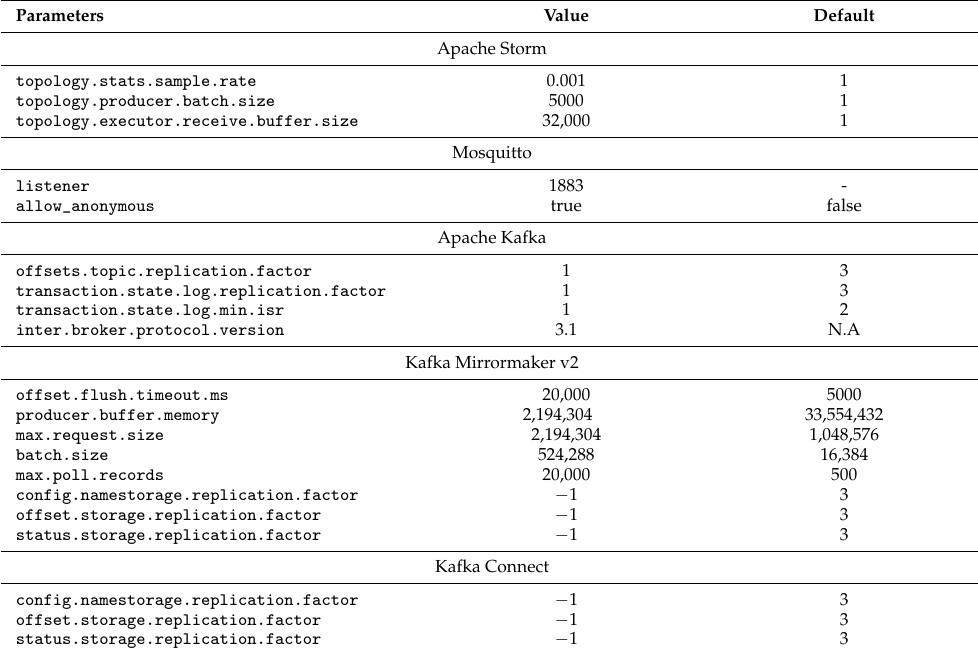
Table 3. Non-default configurations used for the